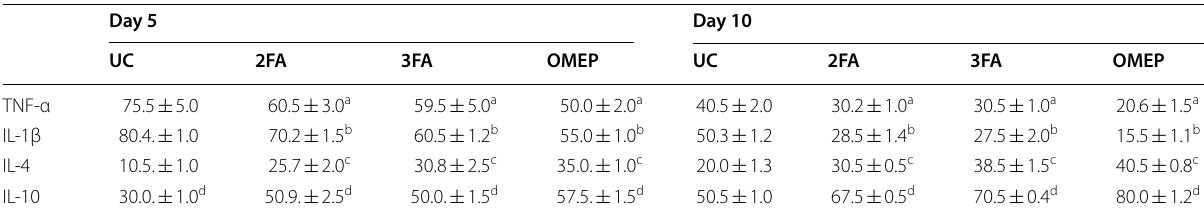
Table 6 Tissue cytokines level in the acetic acid ulcerated stomach treated with Folic acid (FA) and Omeprazole (OMEP)